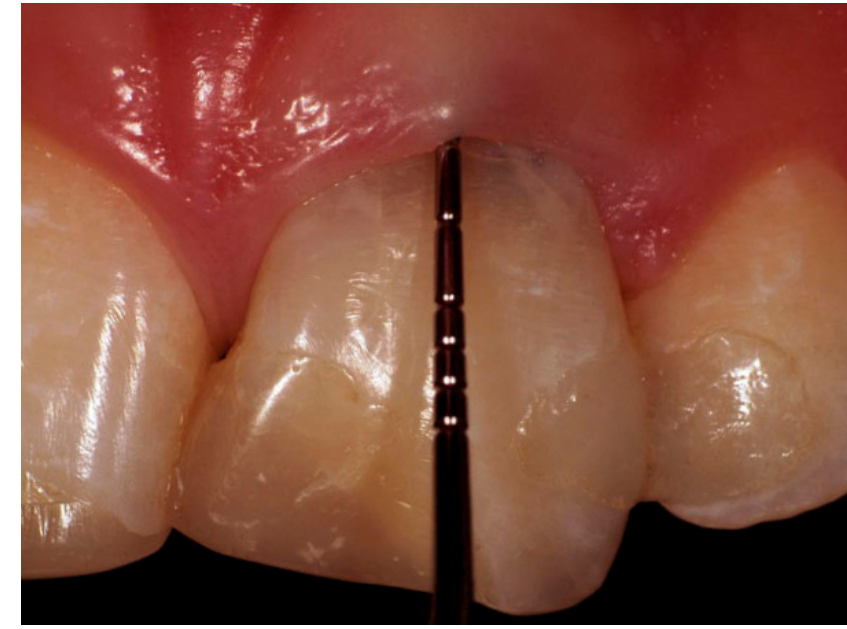
Figure 1. Initial situation at the first trauma, frontal view.